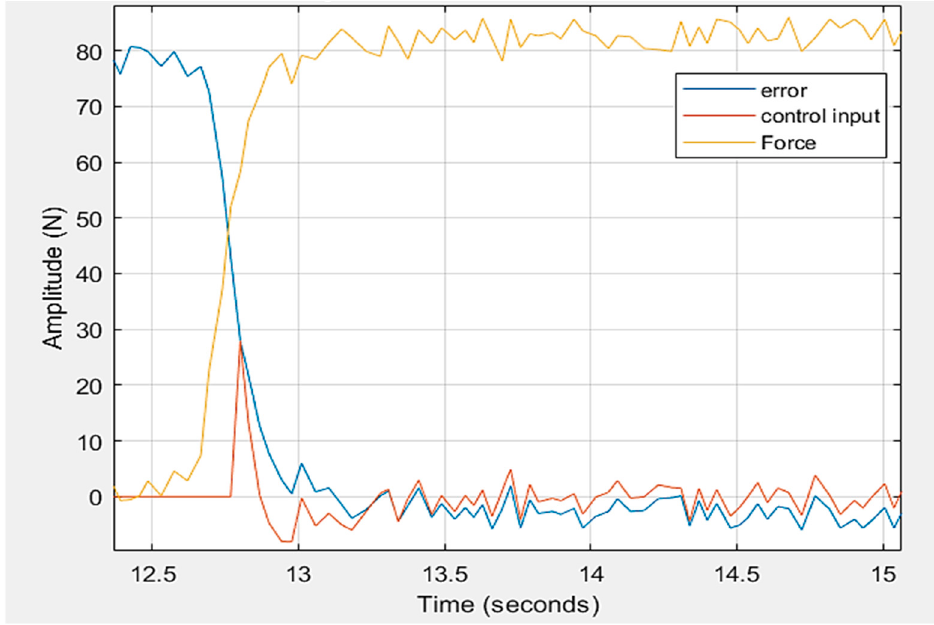
Figure 4. Gripper response under LQR control (results do not change if we increase the time).